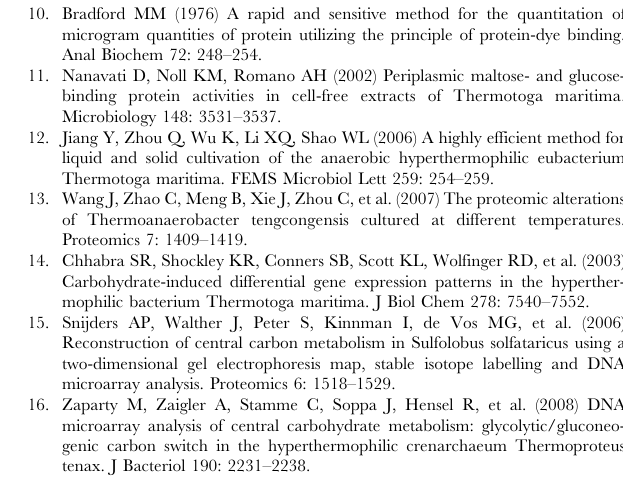
Figure S1 The classification pattern of unique differential proteins in T. maritima . Fig. S1A) exhibit the 41 unique differential proteins in the cytoplasm fraction were categorized into 11 groups, Fig. S1B) exhibit the 37 unique differential proteins in the membrane fraction were categorized into 11 groups. Table S1 The results of identification and classification of the soluble temperature-dependent proteins. Table S2 The results of identification and classification of the membrane temperature-dependent